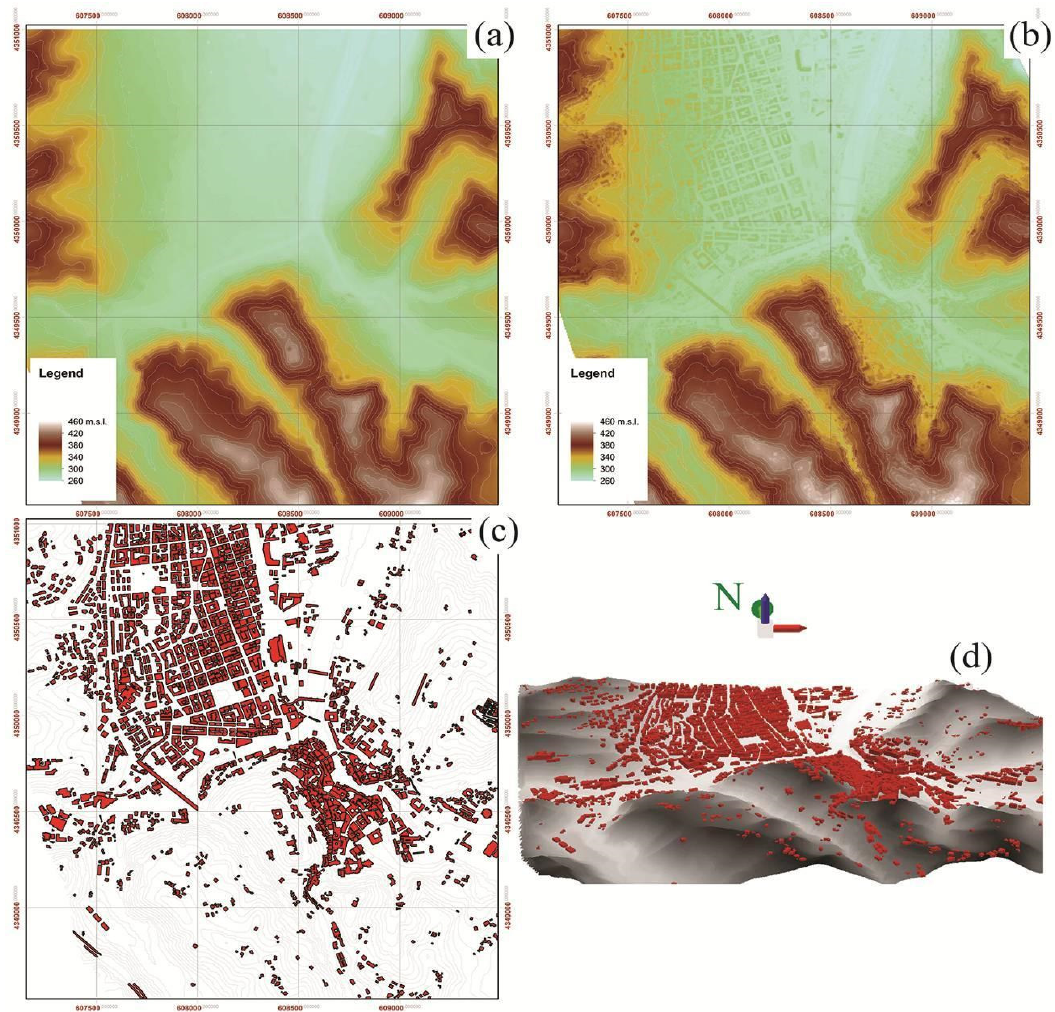
Figure 5. Intermediate products by airborne LiDAR data: ( a ) DTM; ( b ) DSM ; ( c ) map of built areas; and ( d ) 3D view of the buildings projected on the DTM.